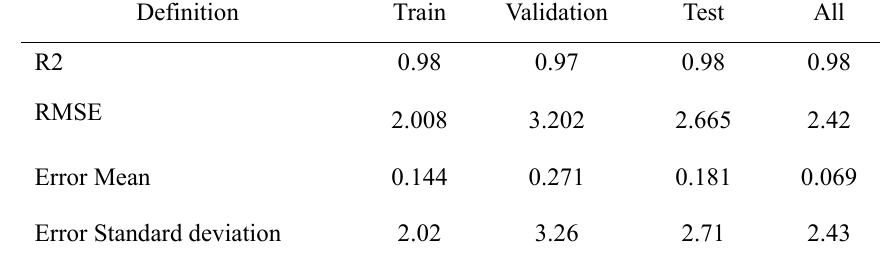
Fig.6. Results of Eq.14 for the considered database. Summary results of the proposed